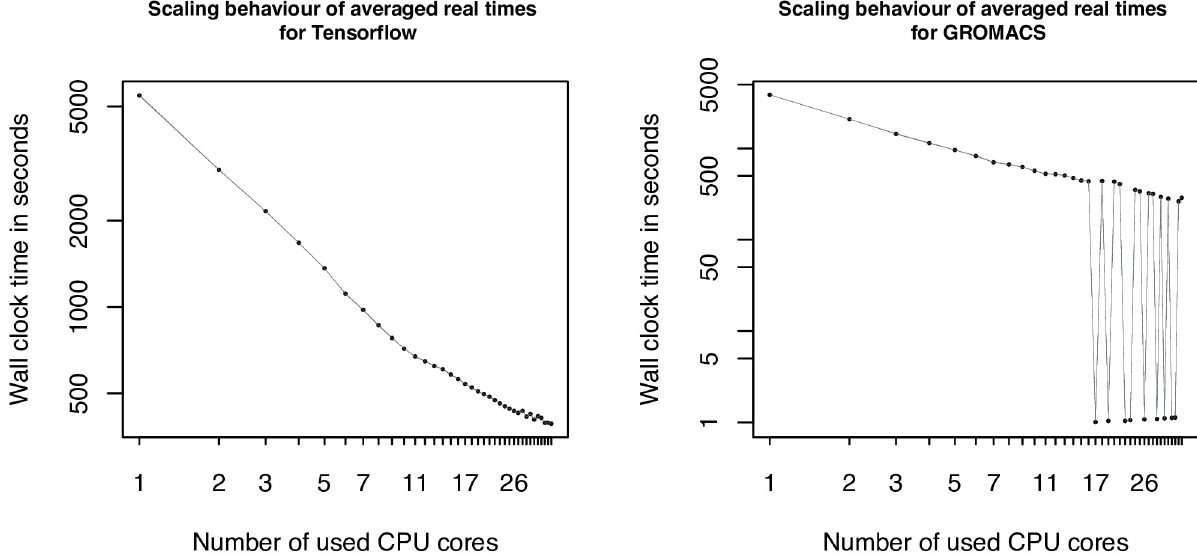
Fig 6. Scaling plots 12—13. Scaling graphs showing the TensorFlow application CIFAR-10 (left) and GROMACS (right) using the long dataset. The number of used cores are represented on the x-axes, whereas the y-axes show the averaged measured wall-times, in different ranges, depending on the tool. The x and y axes are scaled logarithmically to make a linear scaling behavior visible. The borders of the gray area illustrate the minimal and maximal measured values for each used core, but are barely visible as only tiny deviations from the different replicas have been measured.